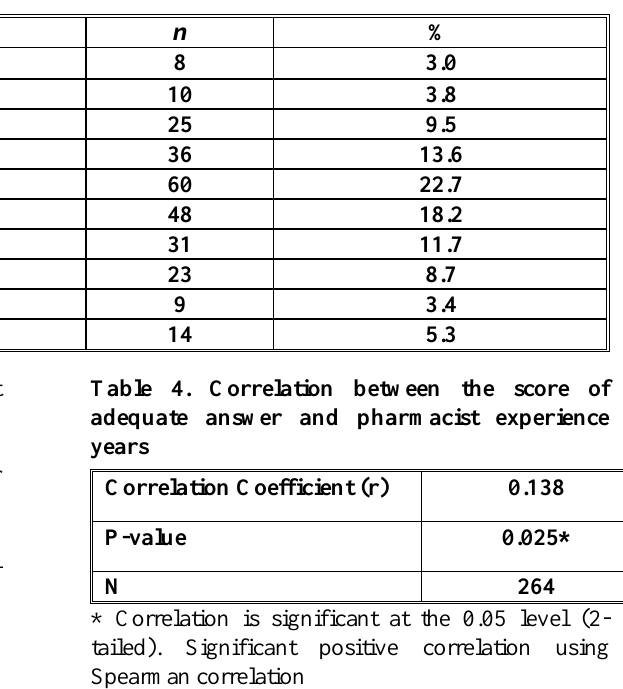
Figure 1. The percentage of pharmacist with correct answers about biosimilar medicines (BSM). The number of participants who adequately answered to the questions about biosimilar Table 3. Frequency distribution of participants according to number of correct answers with respect to knowledge.